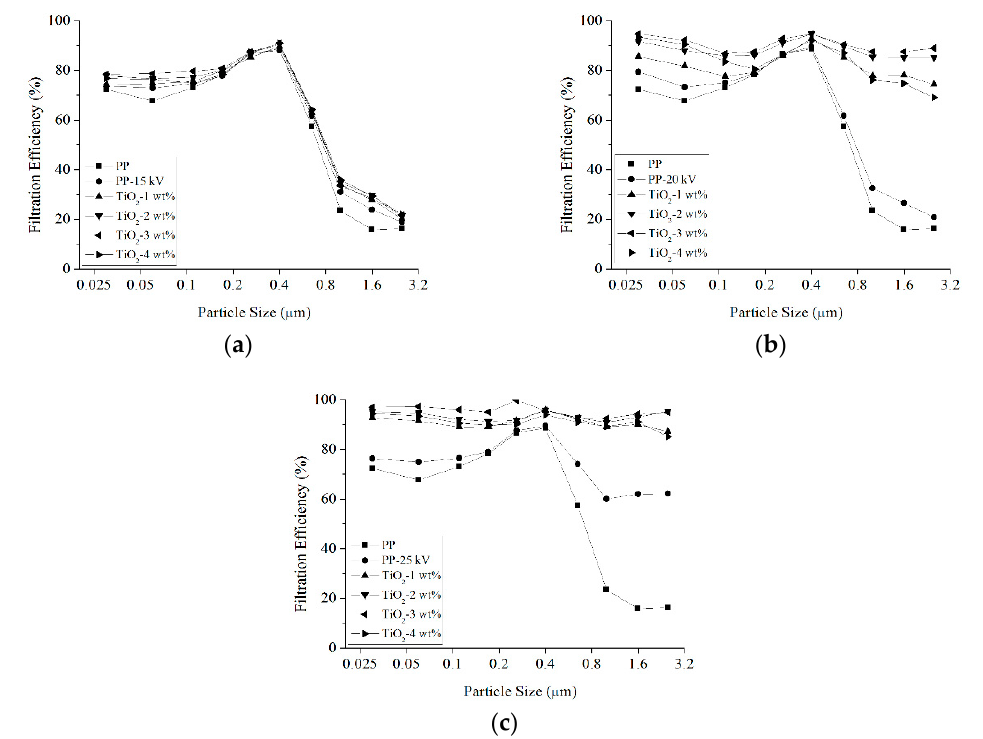
Figure 6. Filtration efficiency of particles at various sizes for electret melt-blown fabrics as related to ratios of 1, 2, 3, and 4 wt% and the electric field intensities of ( a ) 1.5, ( b ) 2.0, and ( c ) 2.5 kV/cm.